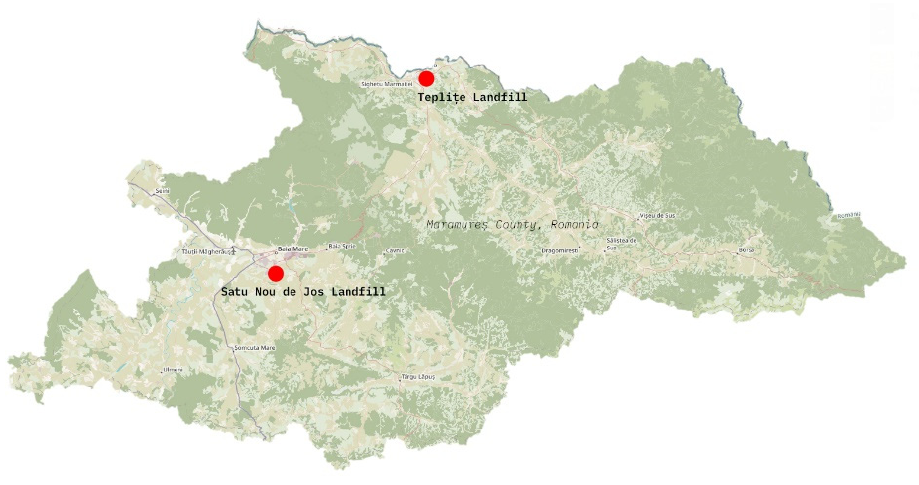
Figure 1. The landfills from Maramures County [23].